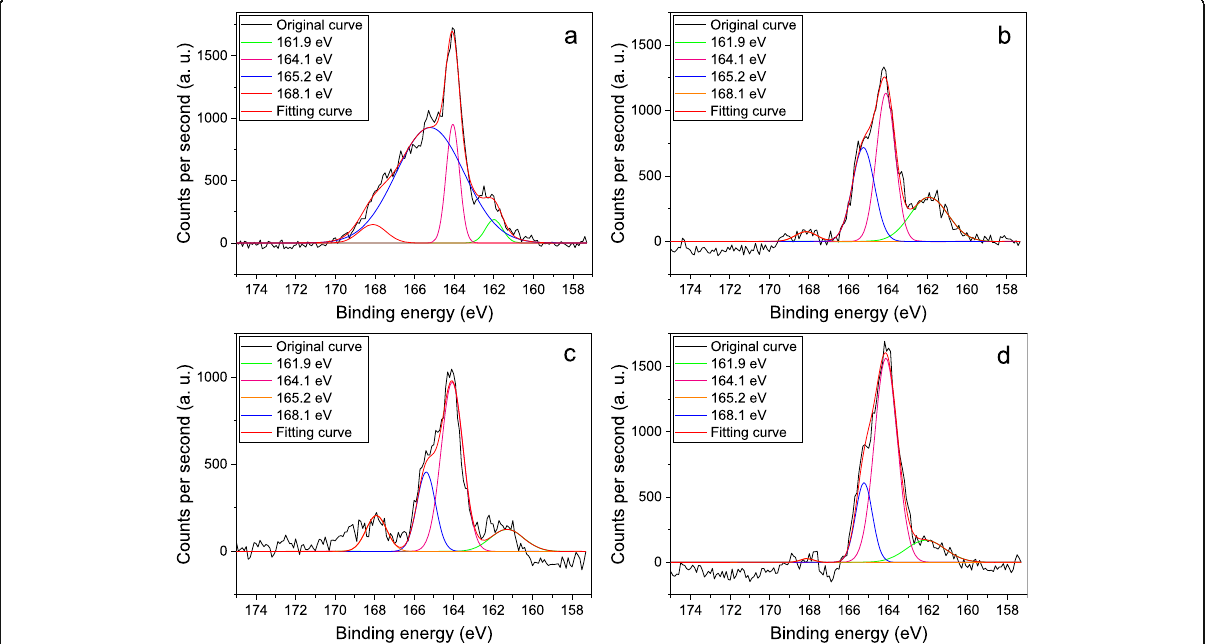
Fig. 2 The high-resolution sulfur (2p) XPS analysis of the SA-GO which is prepared by the reactions of butylamine ( a ), octylamine ( b ), laurylamine ( c ), octadecylamine ( d ), and the sulfur-doped graphene oxide (the oxidation time of the graphene oxide is 24